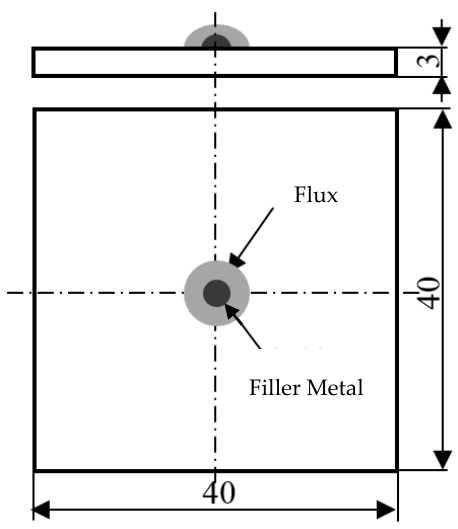
Figure 1. Schematic diagram of the spreading test (mm).